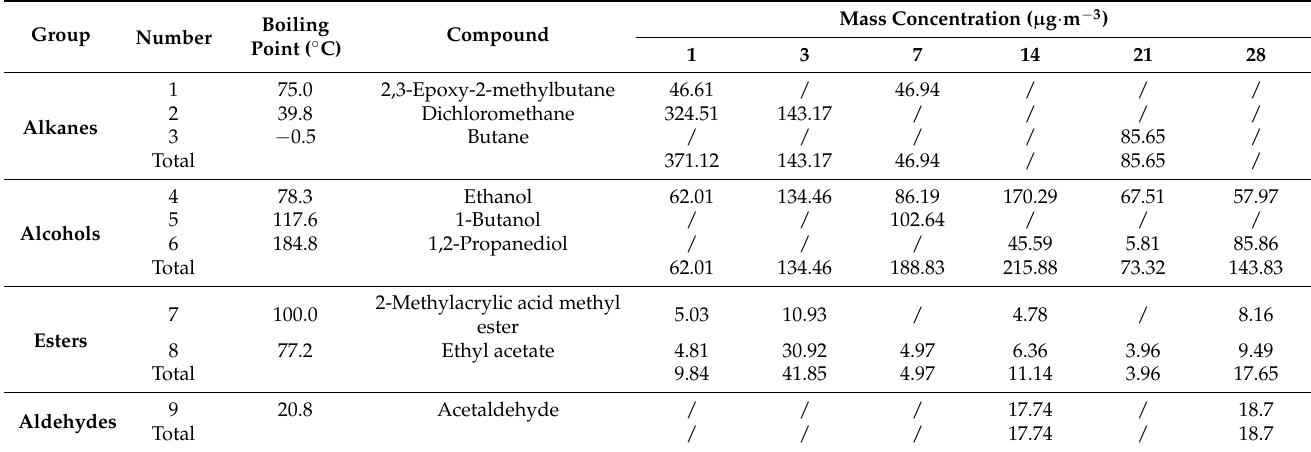
Table 1. The VVOC components of WB-MDF in